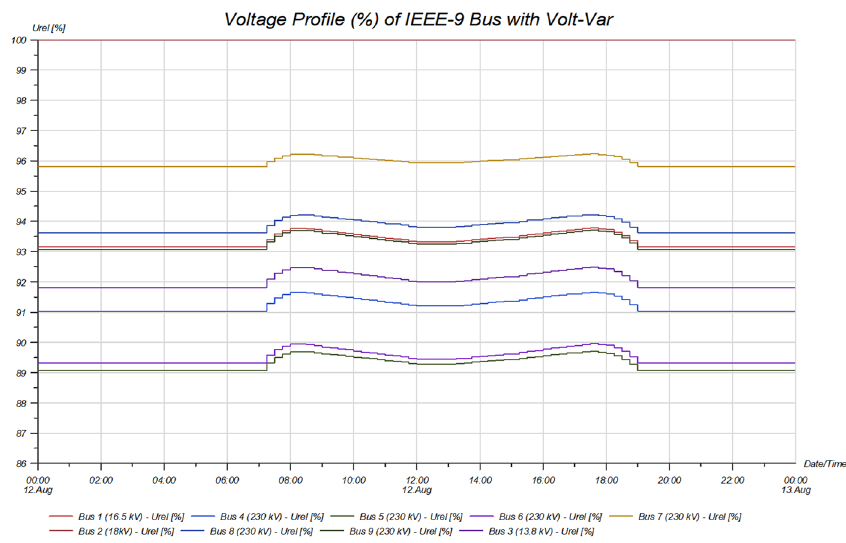
Fig. 14 Voltage profile of IEEE-9 bus after volt-var regulation was implemented on the solar